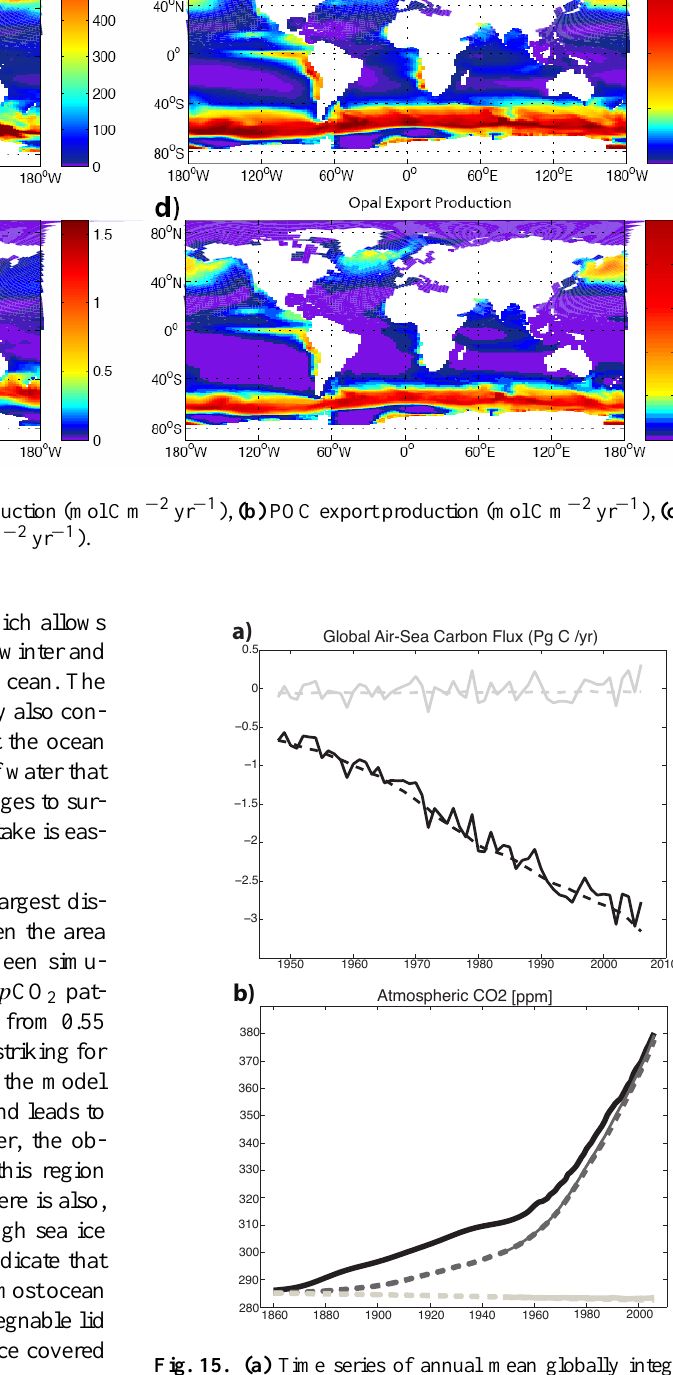
Fig. 15. (a) Time series of annual mean globally integrated air- sea CO 2 flux (PgCyr − 1 , negative downward). Black dashed CLIM+EMS, black solid SYN+EMS, light grey dashed CLIM, light grey solid SYN. (b) Time series of annual mean atmospheric CO 2 concentrations 1860–2007 (ppm). Thick black line observed, dark grey dashed CLIM+EMS, dark grey solid SYN+EMS, light grey dashed CLIM, light grey solid